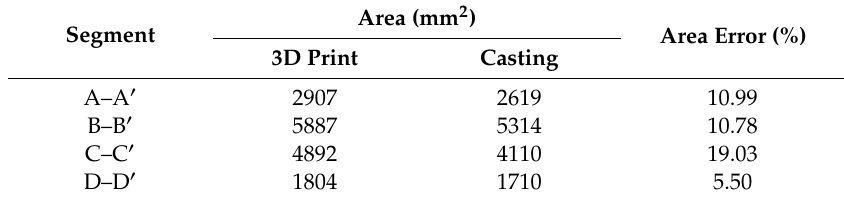
Table 1. Area generated and error from the socket segment obtained by the image processing